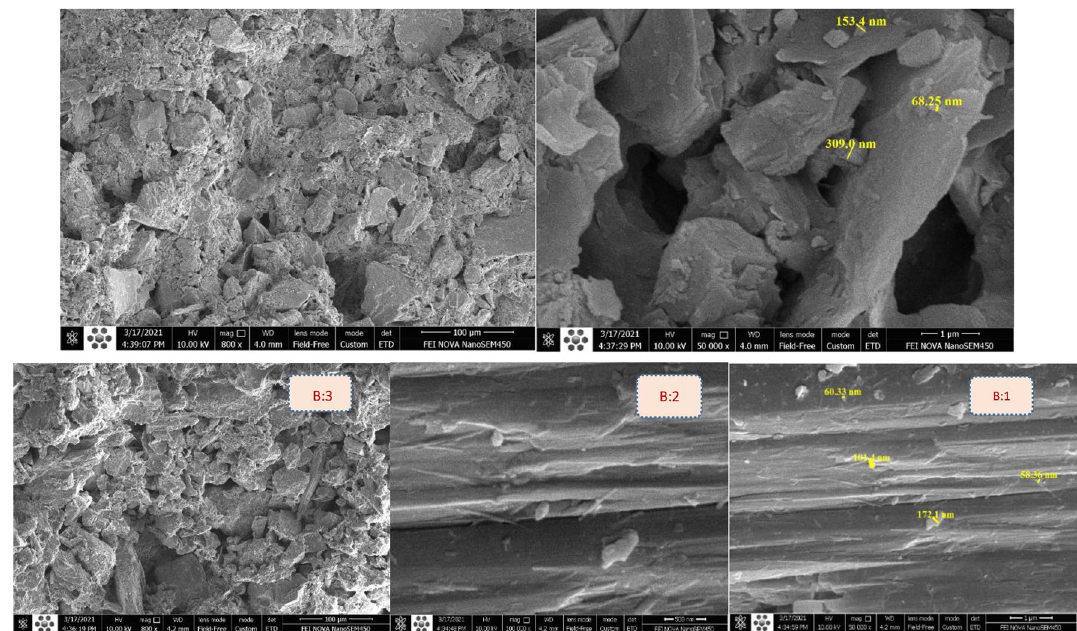
Fig. 7 Sludge SEM image of both processes in optimal condition, A Coagulation and flocculation process, B Hybrid